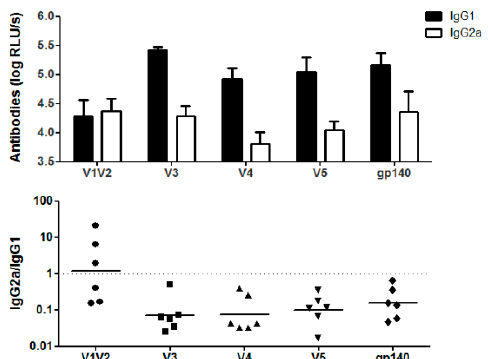
Figure 7. Humoral immune responses after vaccination with truncated variants of Env. Balb/c mice were vaccinated twice with the plasmids encoding the truncated Env-variants V1V2, V3, V4, V5, and the parental gp140 construct, depicted in Figure 1. Two weeks after the booster immunization, the Env-specific antibody responses were determined by ELISA. The upper part shows the levels of IgG1- and IgG2a-antibody response in each group ( n = 6) as mean values with SEM. The lower part shows the ratio of IgG2a to IgG1 calculated individually for each animal with bars indicating the geometrical mean values. Each symbol represents an individual animal.